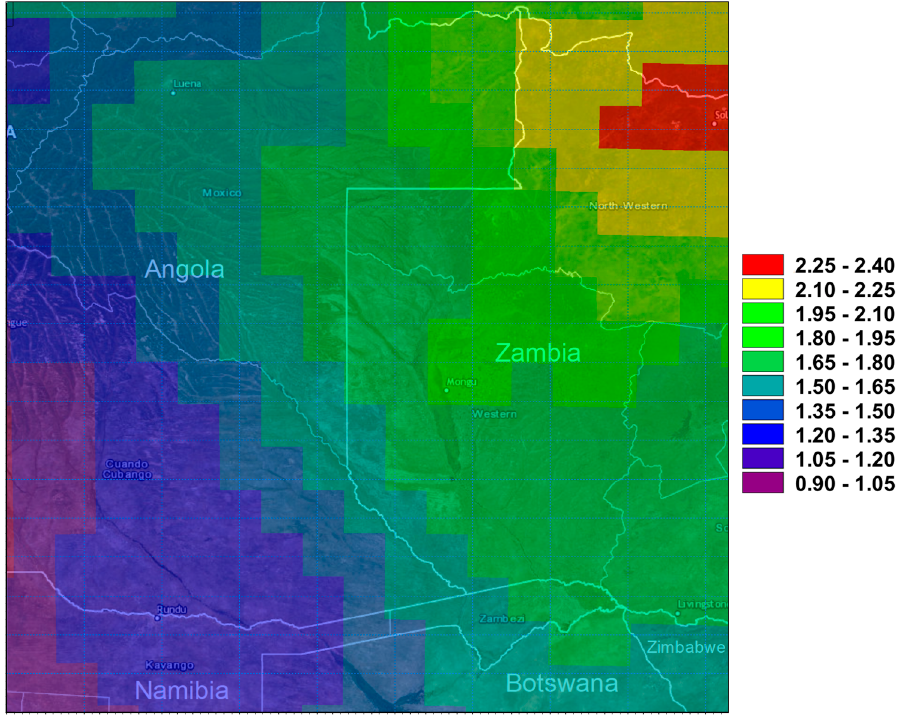
Figure 16. Screenshot of the MIKE-SHE average daily rainfall (mm/day) input grid for the Upper Zambezi River Basin extracted using the Large Basin Data Portal tools from the Earth Science Research Laboratory (ESRL) datasets for the years 2009–2019.